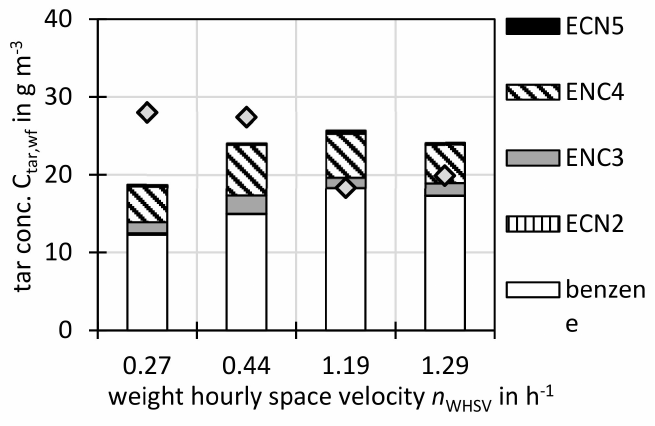
Figure 9. Gravimetric and GC-MS tar concentrations on dry, N 2 -free and STP basis at different weight hourly space velocities.